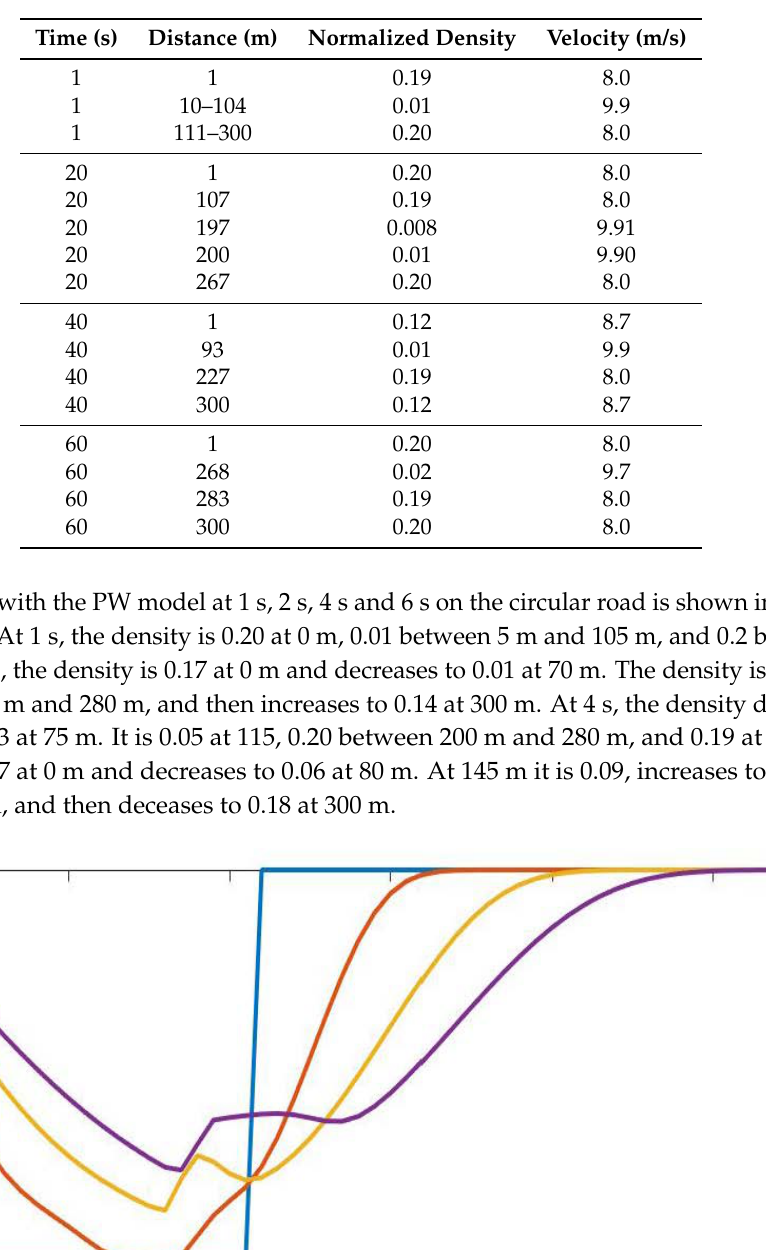
Table 3. Velocity and density with the proposed model at 1 s, 20 s, 40 s and 60 s.